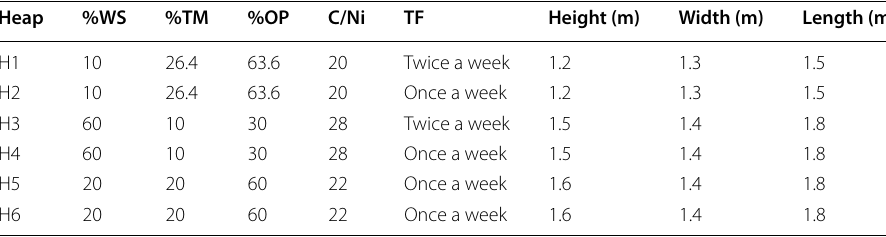
H5 and H6 (identical): heap object of the present study; H1 to H4: subject of a previous study. Their results are used only for statistical